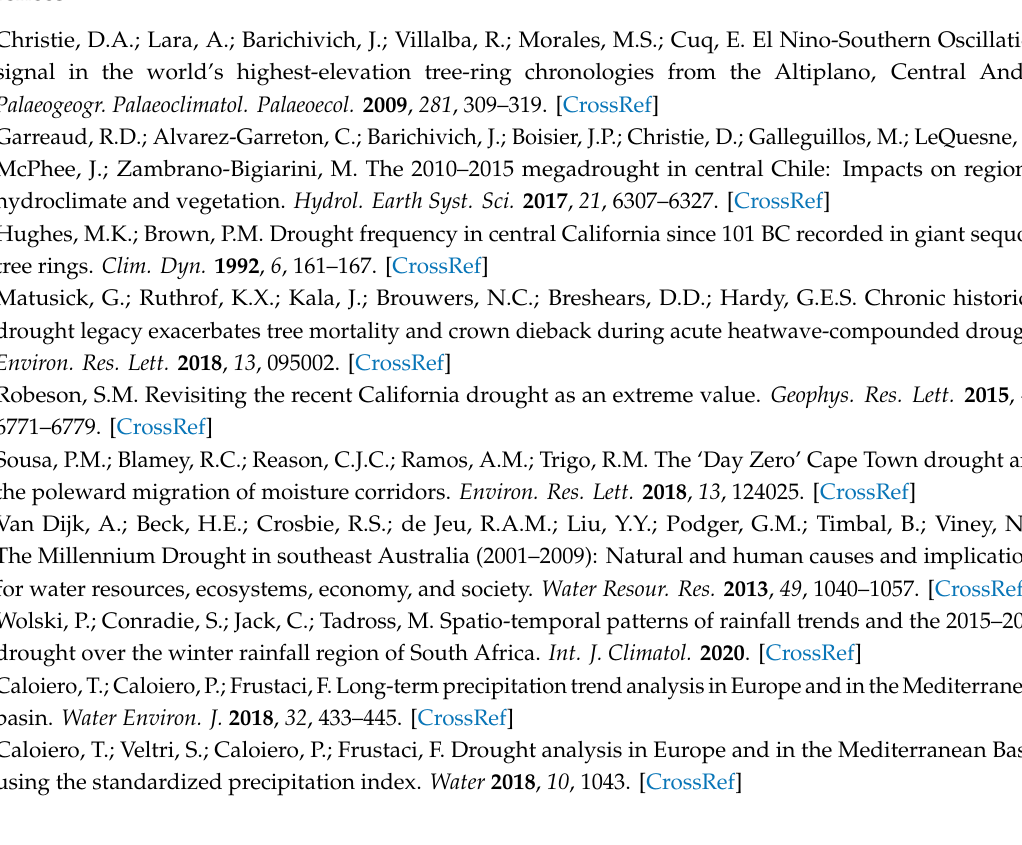
Figure A2. Relationship between mean annual precipitation (mostly concentrated in May.–Jun.–Jul.–Aug.) and mean maximum temperature for Oct.–Nov.–Dec. as of 1950 in central Chile based on weather data for Santiago (Quinta Normal). The figure shows that warmer than average conditions in late spring / early summer tend to be more frequent during drier than average winters ( r ~ − 0.5, p < 0.01). The dashed lines indicate the long-term median values. The filled circles are coloured according to year, from 1950 (dark blue) to 2019 (dark red). The circles indicating 2018 and 2019 are the spring-early summer months prior to the February Yr-1 and Yr-2 pollinator sampling dates. Data from Direcci ó n Meteorol ó gica de Chile (DMC) obtained via the CR2 climate explorer: http: // explorador.cr2.cl /